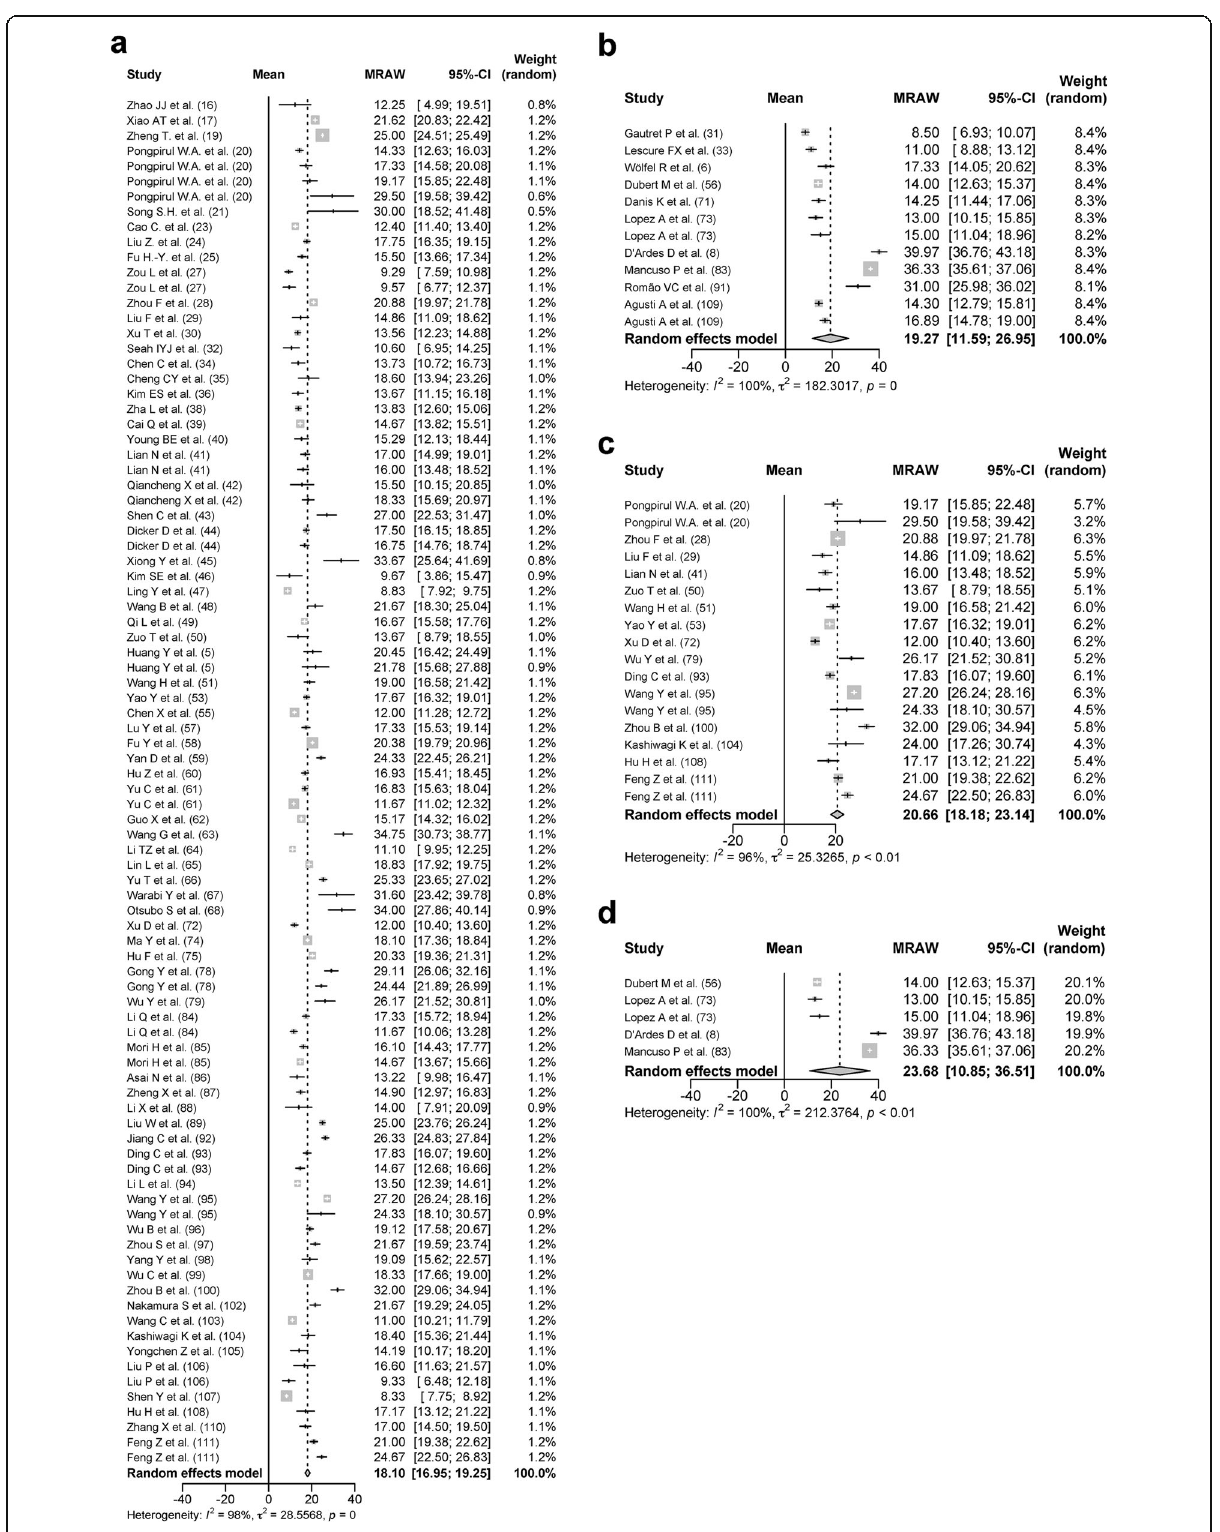
Fig. 9 (See legend on next